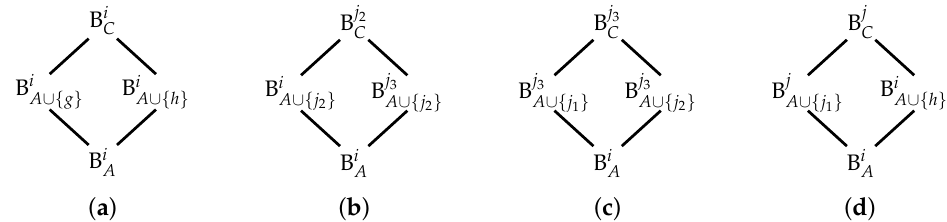
Figure 5. The four possible cases of products different from zero in the dot product of a row of d k with a column of d k + 1